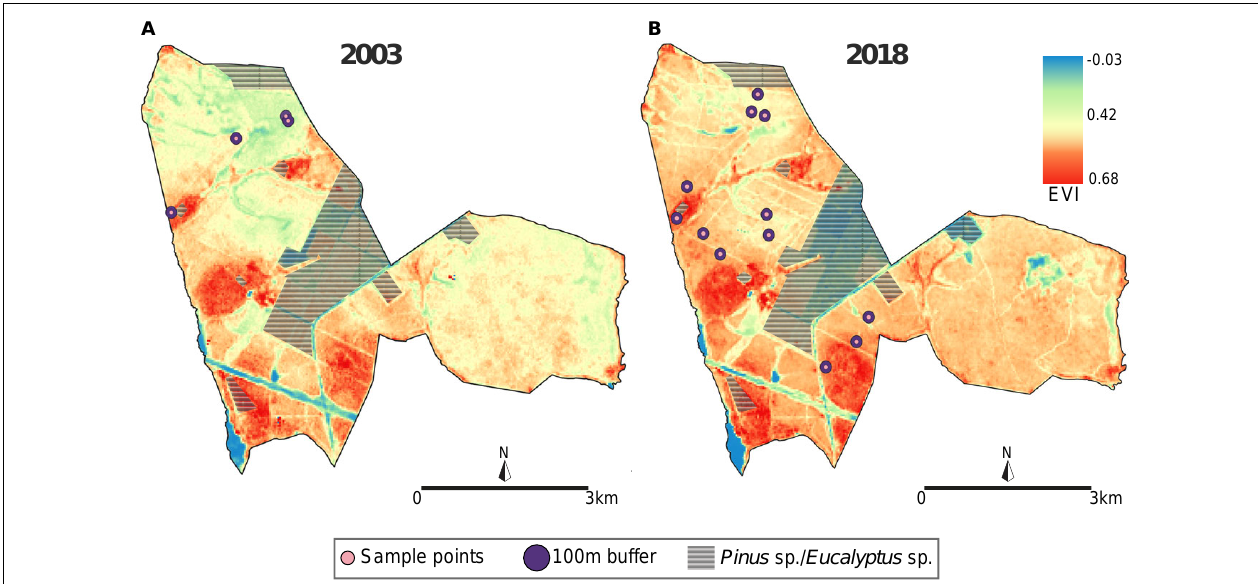
FIGURE 4 | Variation in the enhanced vegetation index (EVI) between the sampling periods of (A) 2003 and (B) 2018 for the study area, Santa Barbara Ecological Station (SBES), São Paulo, Brazil. Dots indicate the location of sampling units.